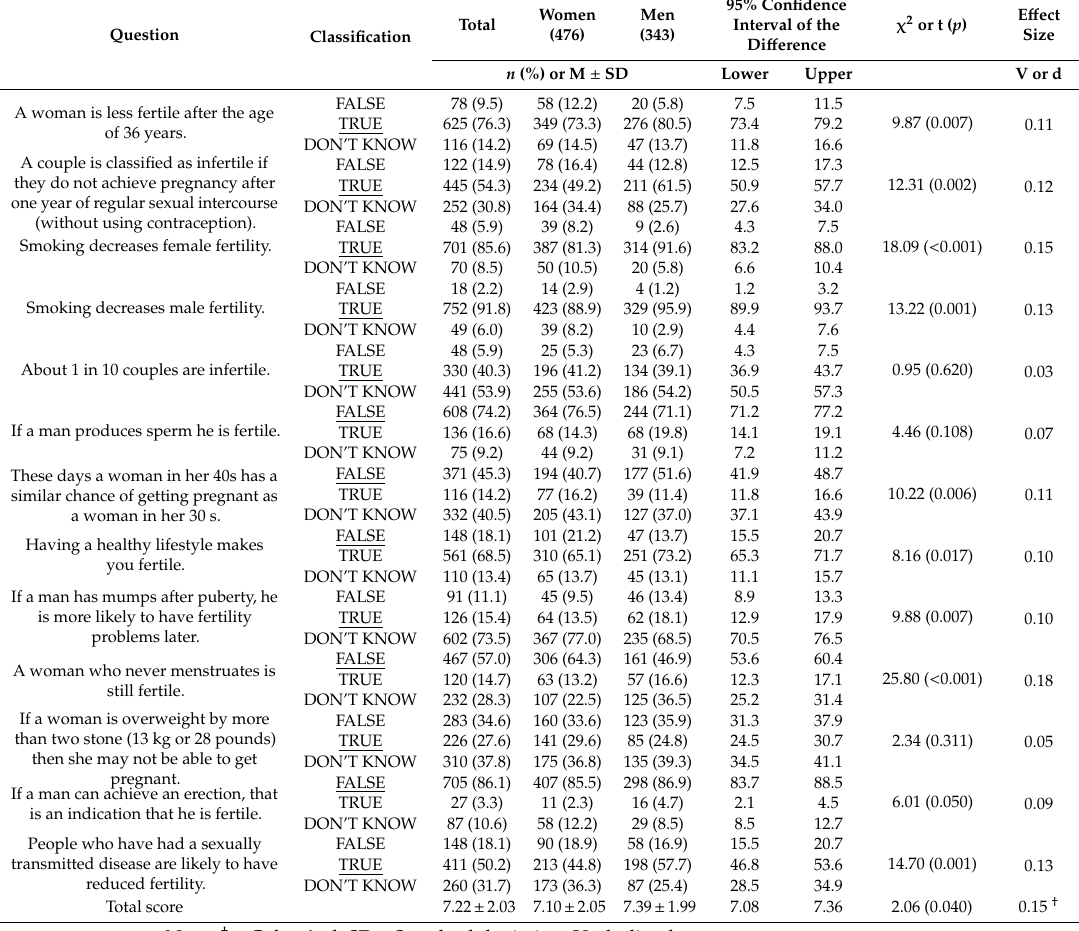
Table 2. Fertility knowledge by gender ( n =